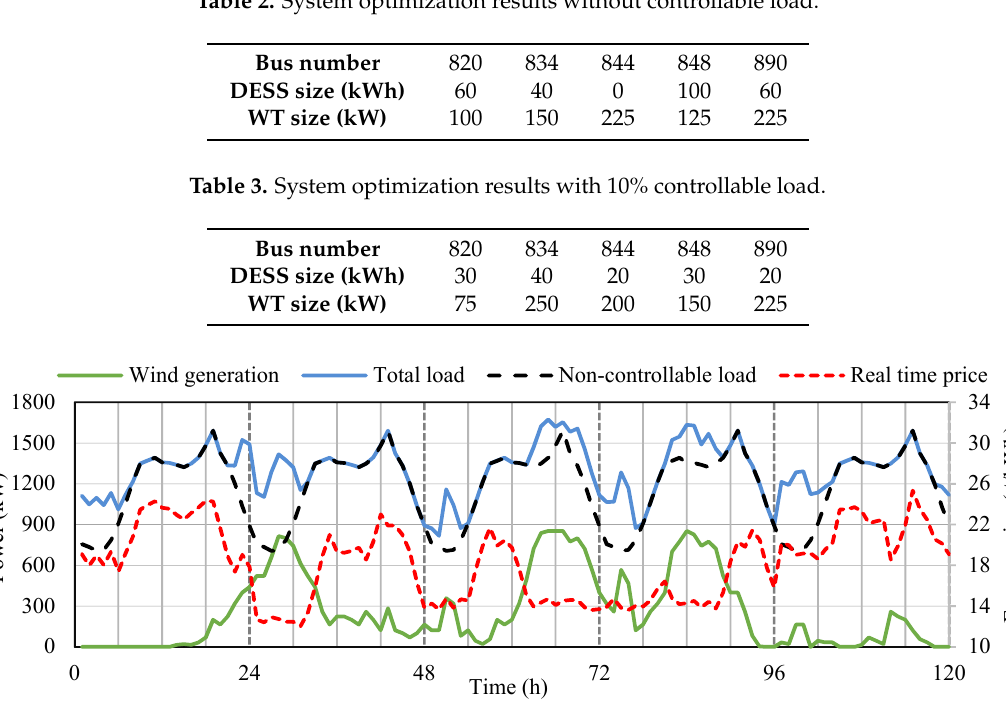
Figure 7. Five day simulation of MG showing the DR versus wind generation and energy dynamic price.